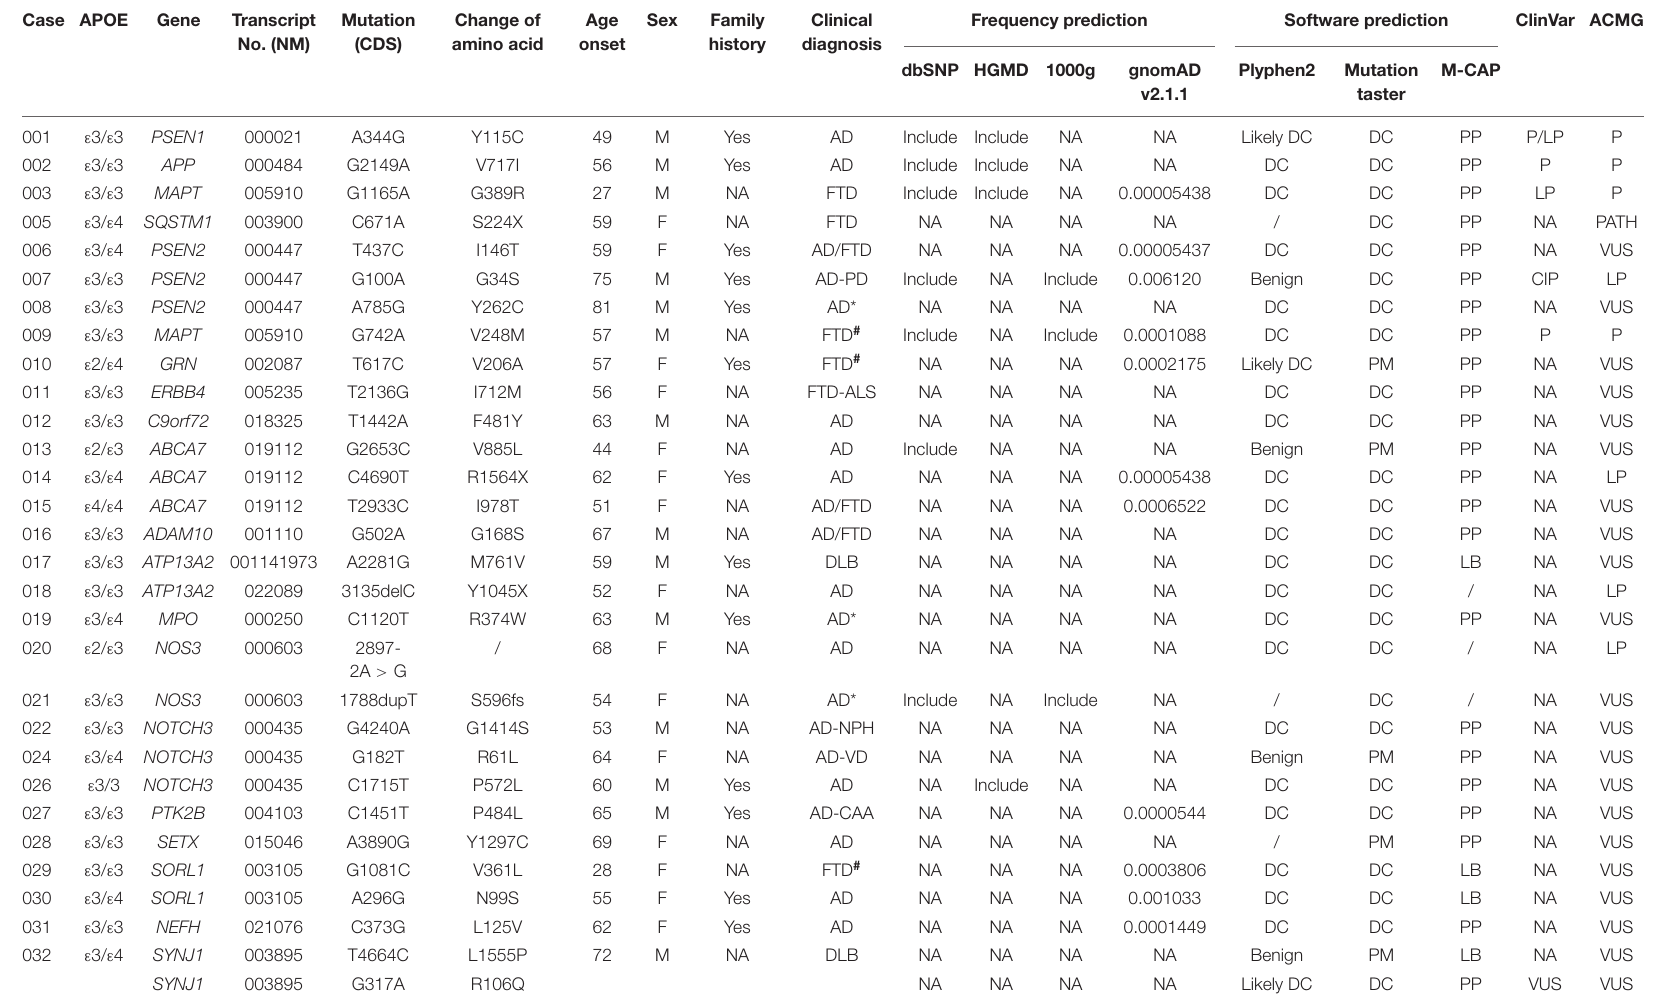
TABLE 2 | Variants in cases with pathogenicity or uncertain